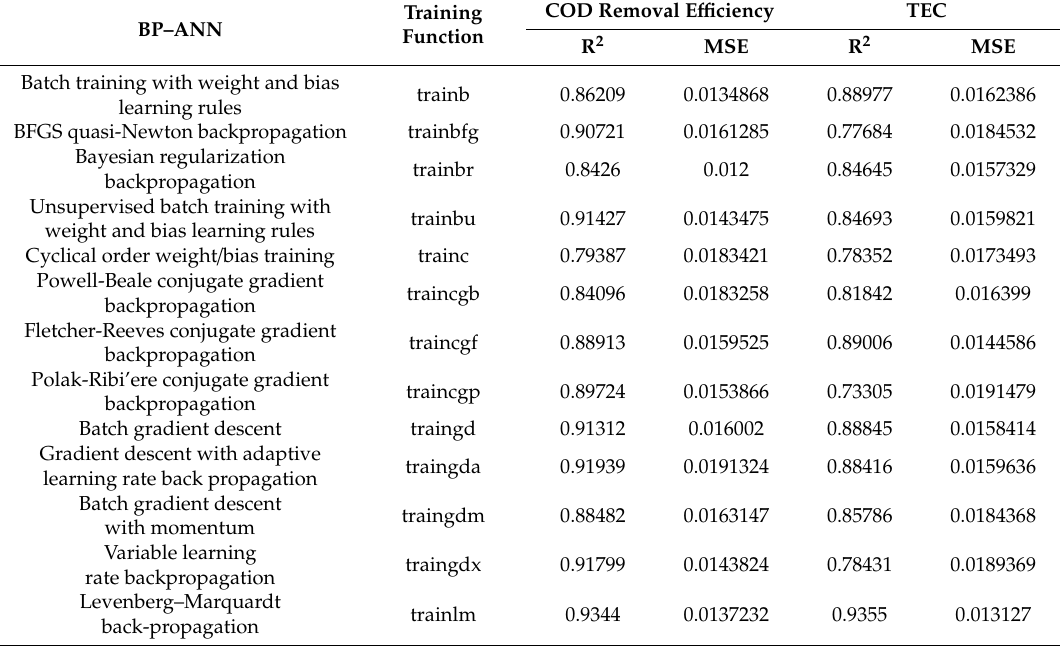
Table 4. Predictions of backpropagation (BP) models with di ff erent training algorithms for the testing dataset.